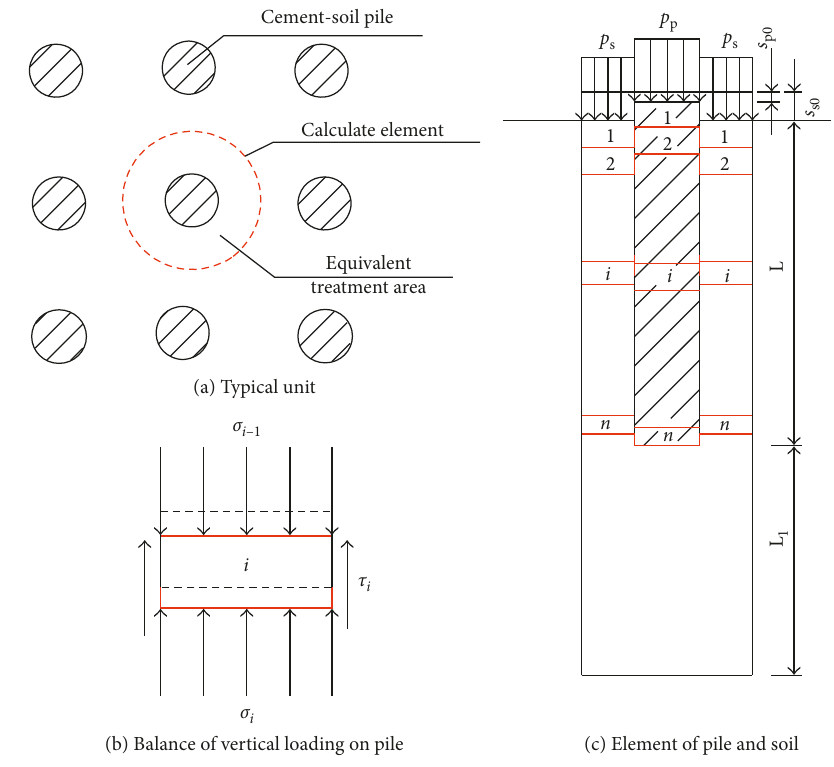
Figure 1: Schematic diagram of pile-soil interaction.